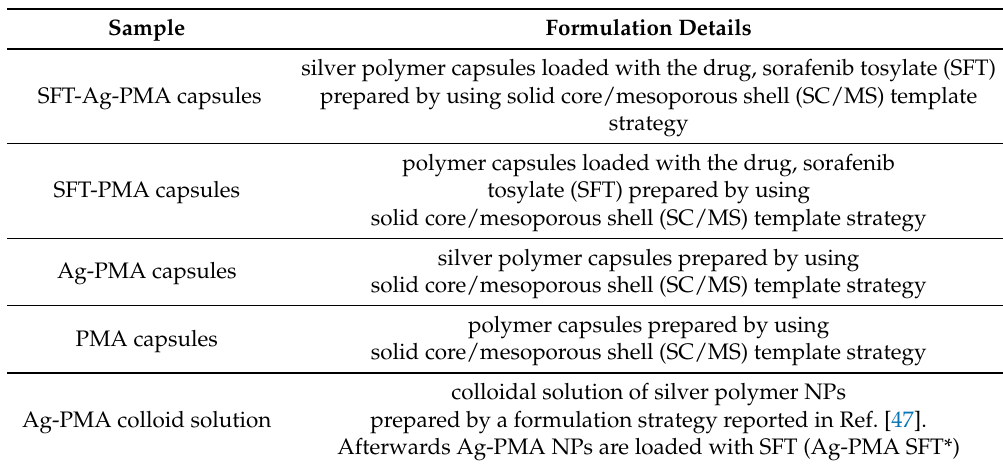
Table 1. Formulation details for the corresponding samples. See the supplementary materials for more